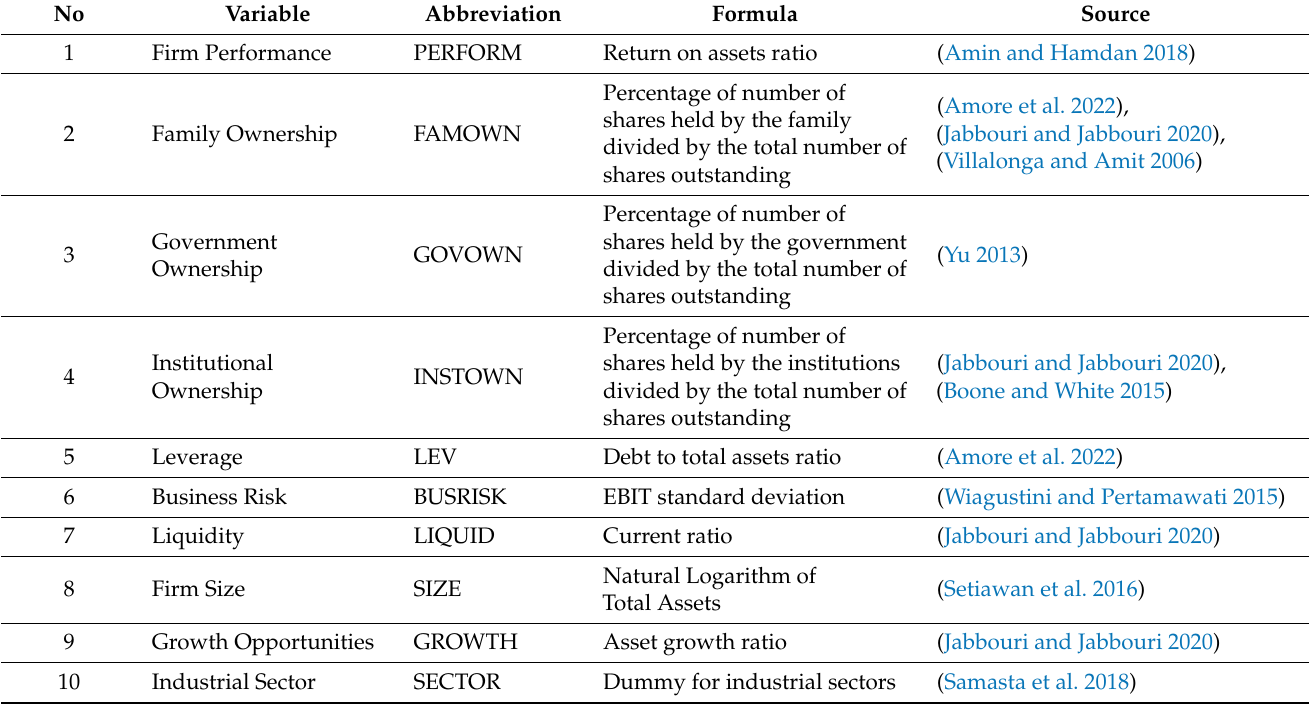
Table 1. Definition of